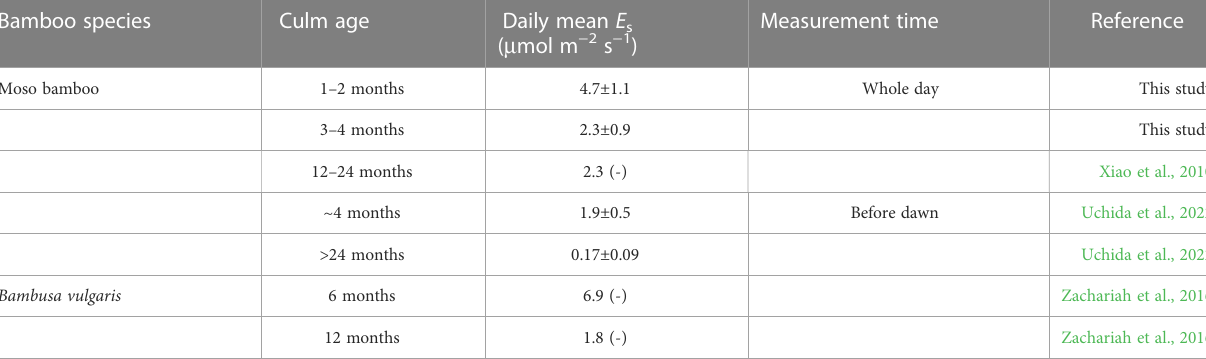
TABLE 5 Comparison of bamboo culm ef fl ux of this study and bamboos in former studies, and contribution of culm photosynthesis to theoretical in situ respiration. Bamboo